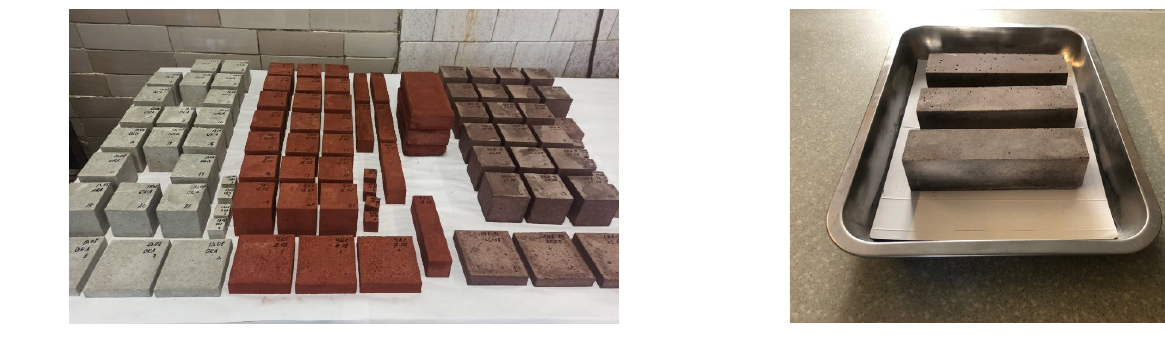
Figure 4. Photos of concrete samples made for research. Table 1. Composition of